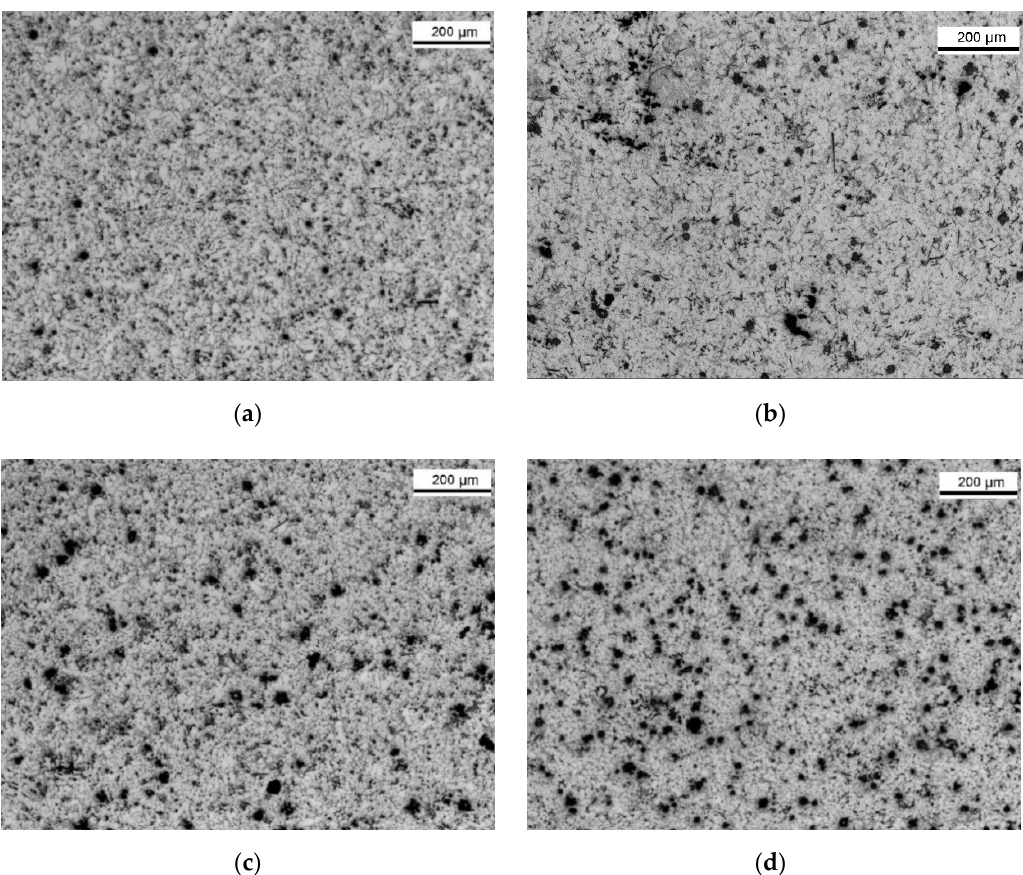
Figure 5. Etched microstructure of ( a ) Alloy 1, SF = 1.32, ( b ) Alloy 13, SF = 1.82, ( c ) Alloy 15, SF = 2.21, and ( d ) Alloy 18, SF = 2.90; the Fe-rich particles appear dark.